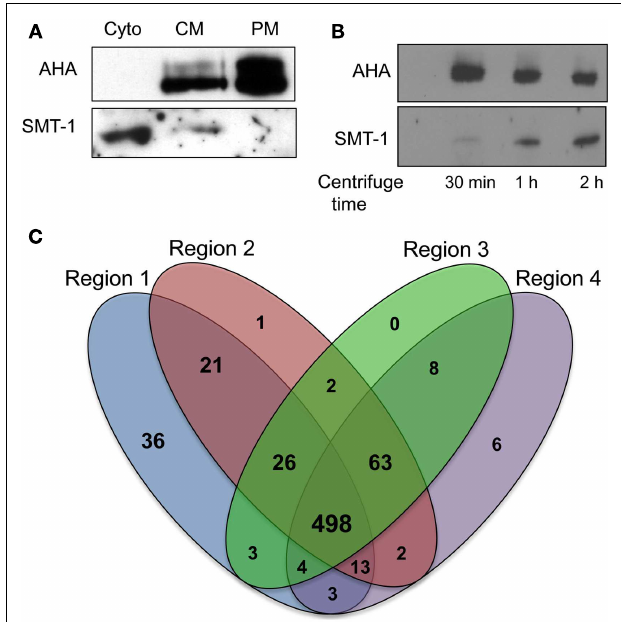
FIGURE 2 |Application of plasma membrane enrichment strategy to analysis of maize primary roots. (A) Proteins from steps of the enrichment procedure were analyzed by immunoblotting with organelle specific markers (Cyto, cytosolic fraction; CM, crude microsomal fraction; PM, plasma membrane-enriched fraction). Equal amounts of proteins from each fraction were analyzed with antibodies specific for a plasma membrane H + -ATPase (AHA) or an endoplasmic reticulum integral membrane sterol methyltransferase (SMT-1). (B) Increasing time